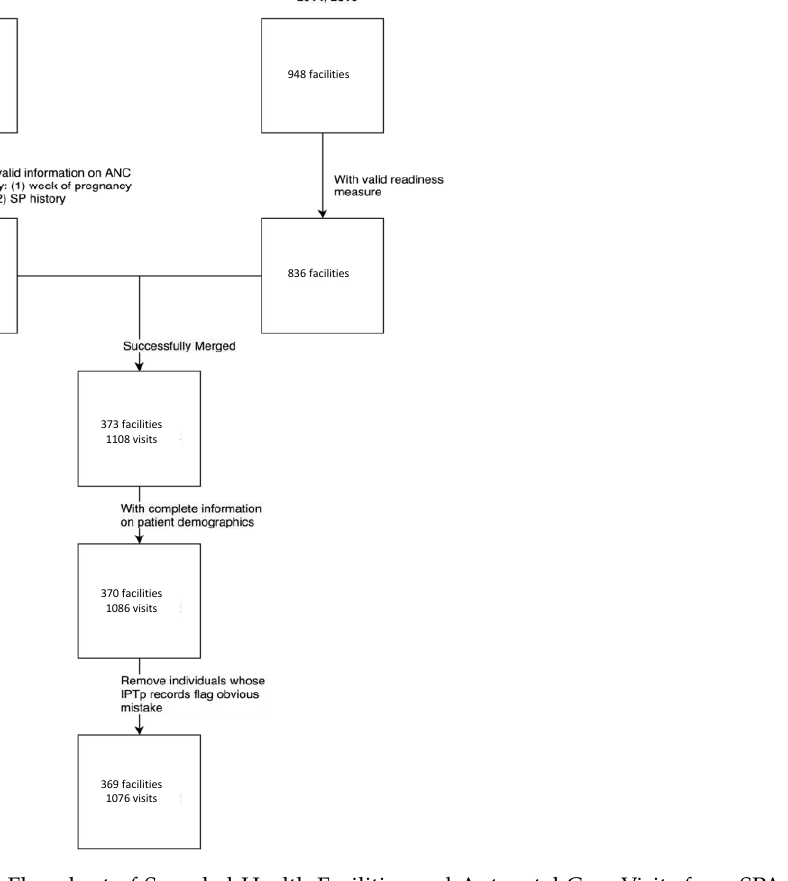
Figure A1. Flowchart of Sampled Health Facilities and Antenatal Care Visits from SPA Surveys Conducted in 2014 and 2016.